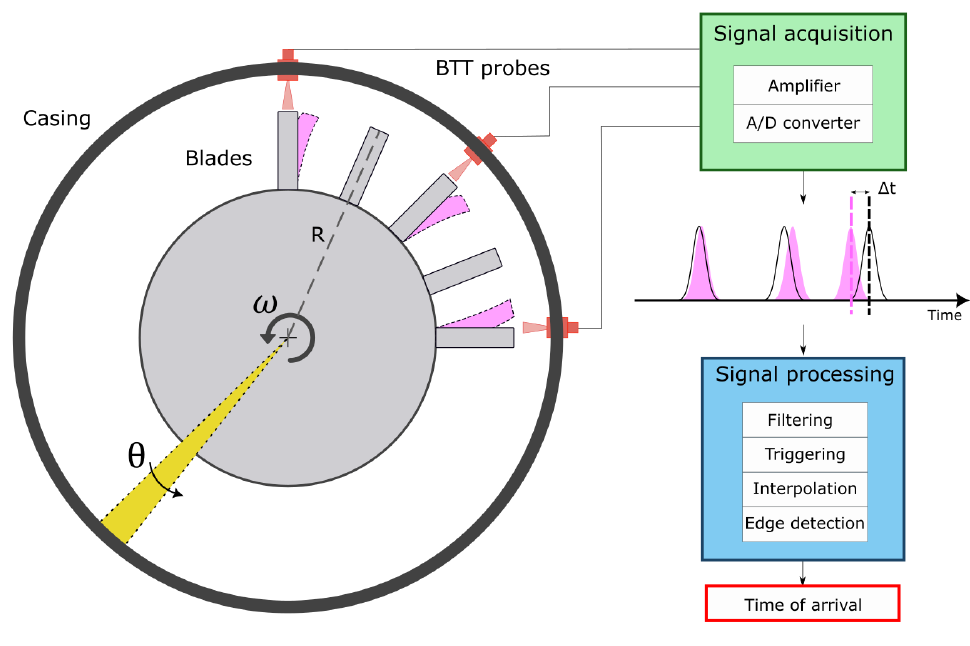
Figure 1. BTT measurement